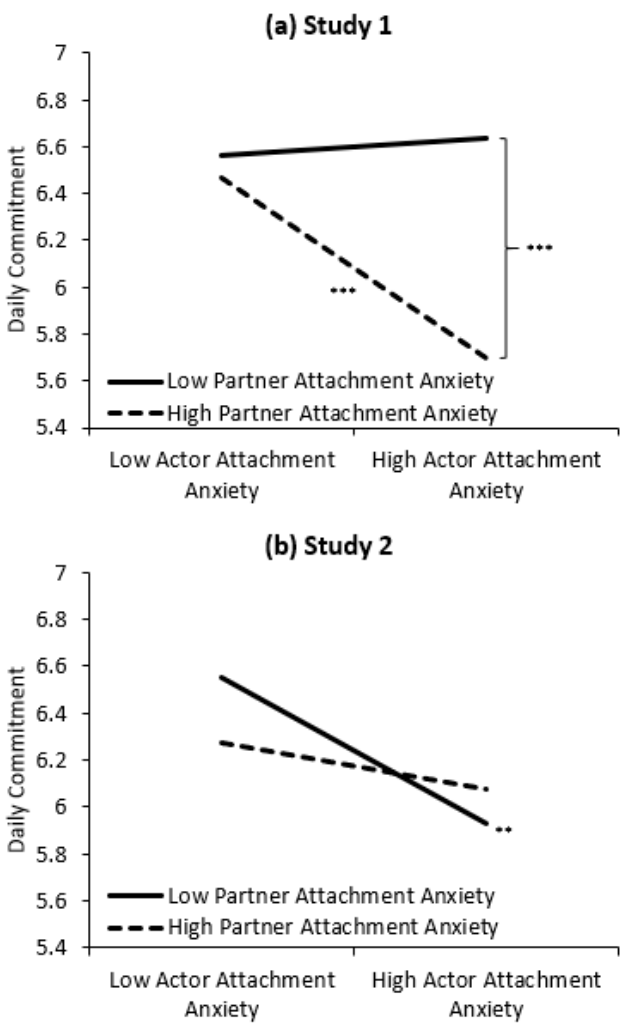
Figure 2. The e ff ects of actor and partner attachment anxiety on daily commitment in ( a ) Study 1 and Figure 2. The effects of actor and partner attachment anxiety on daily commitment in (a) Study 1 ( b ) Study 2. Note . The interaction e ff ect was not significant in Study 2 but was presented for comparison across studies. Low and high levels of actor and partner attachment anxiety represent 1 SD below and and (b) Study 2. above the mean. The simple e ff ects of the slopes and contrasts are marked *** p < 0.001 and ** p <